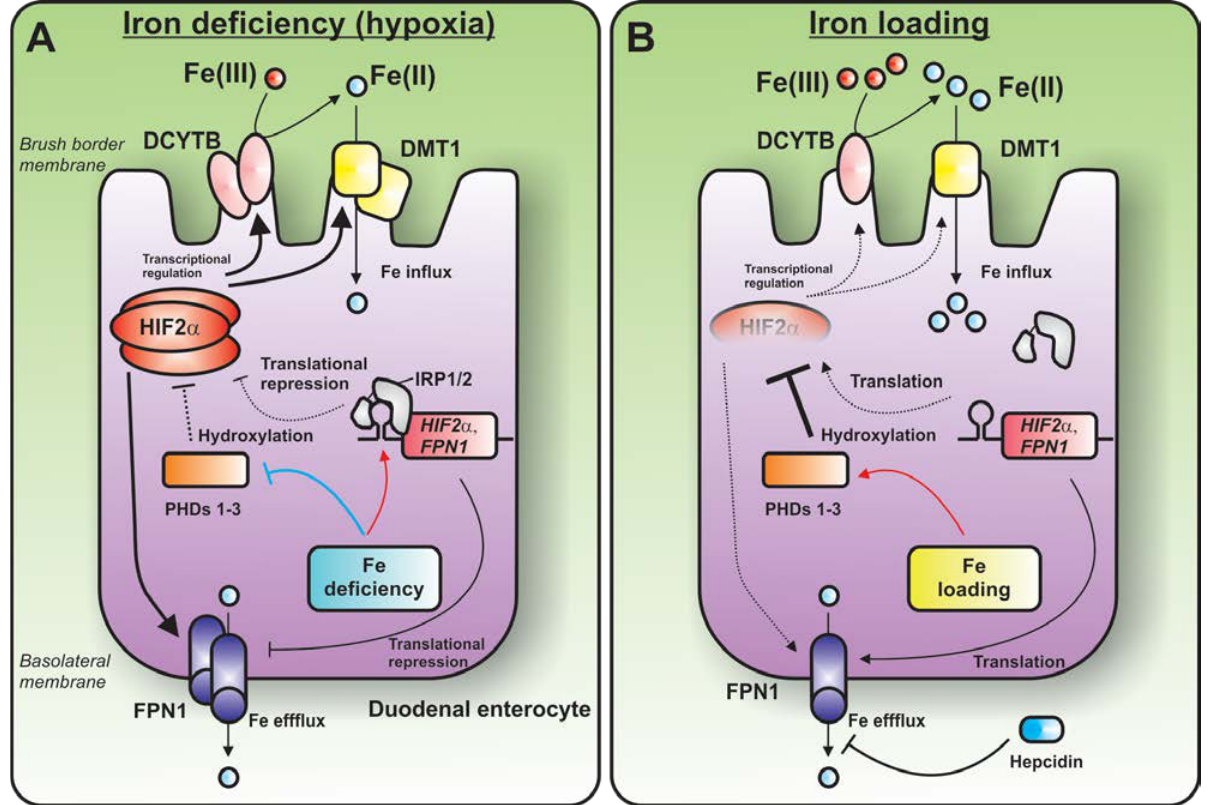
Figure 2. Model for the IRP1-HIF2α axis in regulating DCYTB and dietary iron absorption. ( A ) Under conditions of iron deficiency (as well as hypoxia or increased erythropoietic drive), the expression of HIF2α is increased in the duodenal enterocyte. This leads to transcriptional up-regulation of key iron-metabolism proteins, including DCYTB, DMT1 and FPN1. Specifically, the increase in HIF2α leads to an augmentation of DCYTB and DMT1 in the brush border ( i.e. , apical) membrane of the duodenal enterocyte and an increase in FPN1 levels in the basolateral membrane. HIF2α has been shown to bind to HRE elements in the regulatory regions of the promoters for DCYTB and DMT1. HIF2α is also regulated at the post-transcriptional level (as a consequence of the IRE in its 5′-UTR) and post-translational level (as a consequence of PHD activity). Under conditions of iron deficiency in the duodenum, although the increased IRE-binding activity of the IRP1 would tend to decrease HIF2α translation, the stabilizing effect of low PHD activity on HIF2α protein levels may predominate, leading to a net increase in HIF2α and a consequent up- regulation of DCYTB and DMT1. ( B ) In contrast, under conditions of high iron in the duodenum, HIF2α is translationally derepressed by IRP1, yet PHD activity is likely to be increased, leading to increased HIF2α hydroxylation and proteasomal degradation. The net effect is a decrease in HIF2α levels, resulting in decreased DCYTB, DMT1 and perhaps FPN1